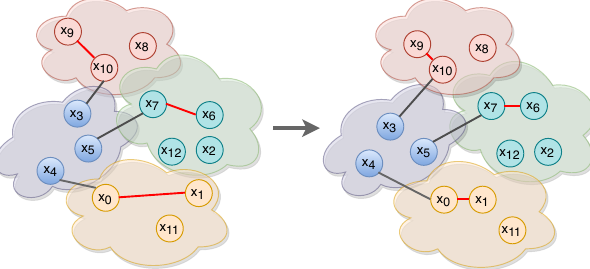
Figure 3. Triplet loss pairs every anchor ( x 0 , x 7 , x 10 ) with a single positive ( x 1 , x 6 , x 9 ) and negative ( x 4 , x 5 , x 3 ) sample respectively. In this figure, red-colored lines connect anchors and positive samples. Black-colored lines connect anchors and negative